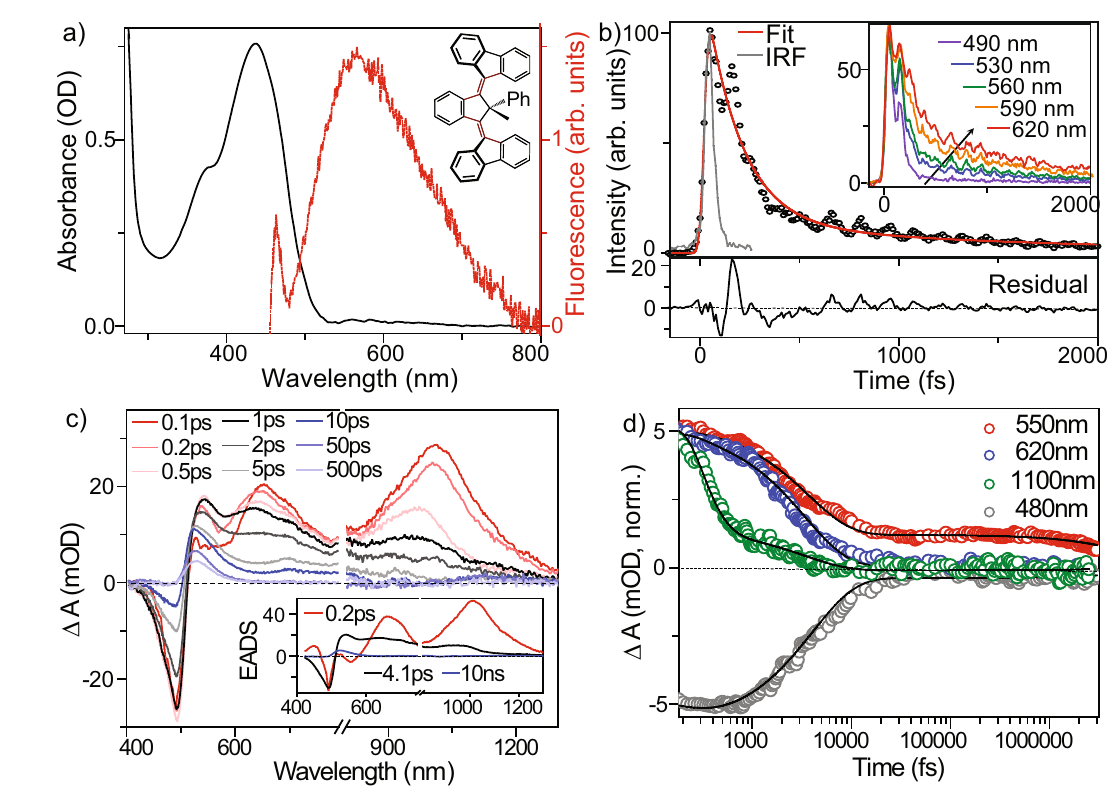
Fig. 2 | Electronic spectra and excited state dynamics of 3GMph. a Steady-state absorption (black) and emission (red) spectra of 3GMph in ACN. Inset: chemical structure of 3GMph. b Time-resolved fl uorescence measured at 560nm after excitation at410nm. The red line showsthe fi t to a biexponentialfunction and the bottom panel is the residual, which is oscillatory, indicating a role for coherently excited vibrational modes in excited state dynamics. The grey line shows the instrument response (width 43fs). Inset: fl uorescence dynamics at fi ve emission wavelengths; c Transient vis-NIR absorption spectra at different time delays